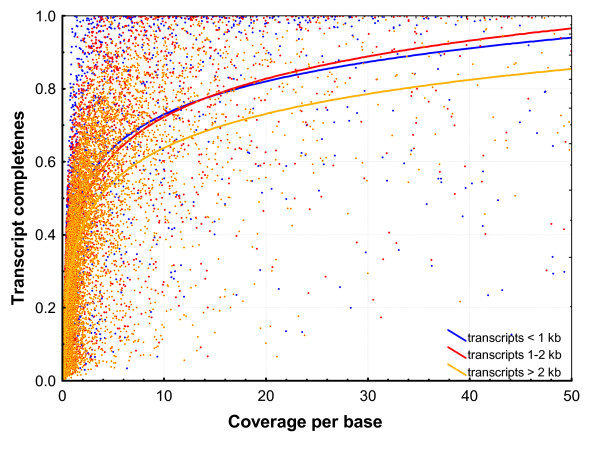
The relationship between transcript completeness and coverage. The per base coverage is averaged over the total transcript length. Only coverages up to 50 × are shown. Logarithmic curves were fitted to three subsets of the data: transcripts < 1 kb, 1-2 kb and > 2 kb.